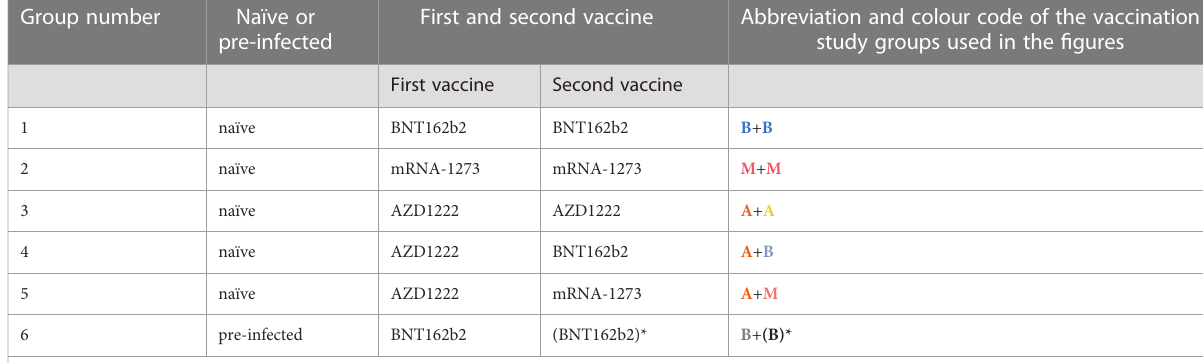
TABLE 1 Vaccination study groups. Group